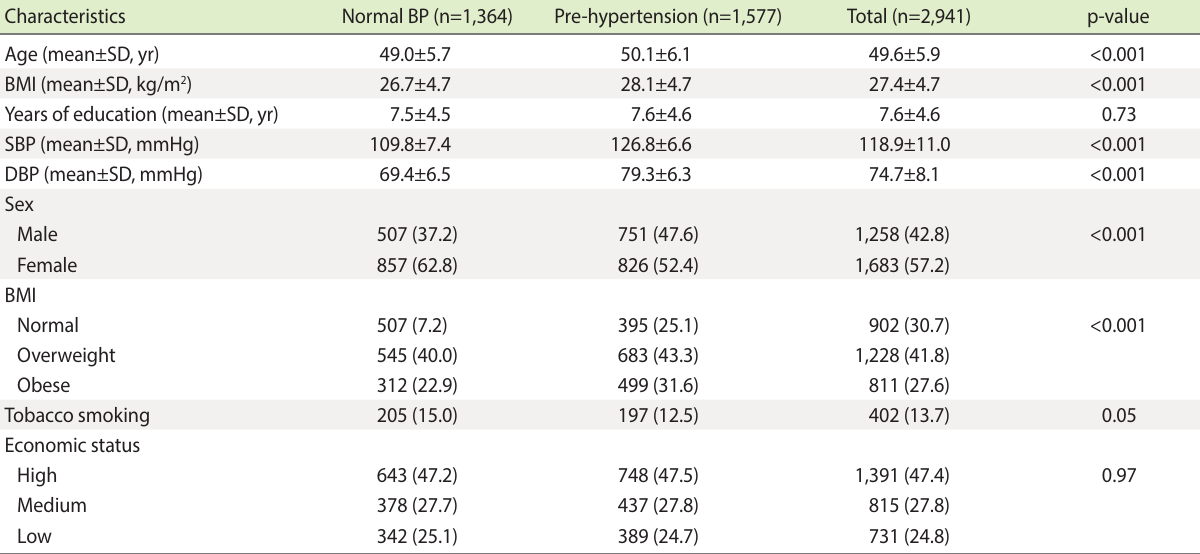
Table 1. Comparison of baseline characteristics among participants with normal BP and pre-hypertension